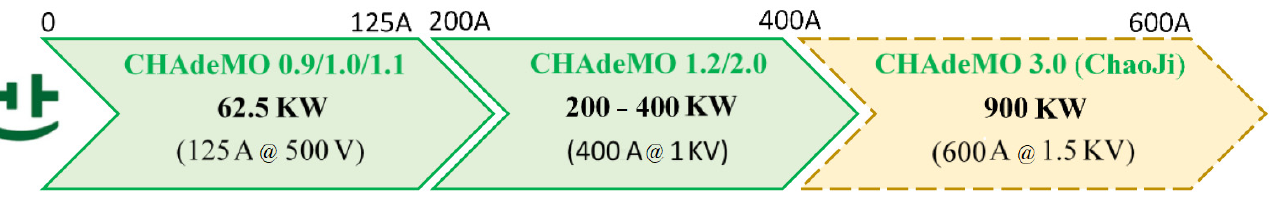
Figure 20. CHAdeMO standard specifications.